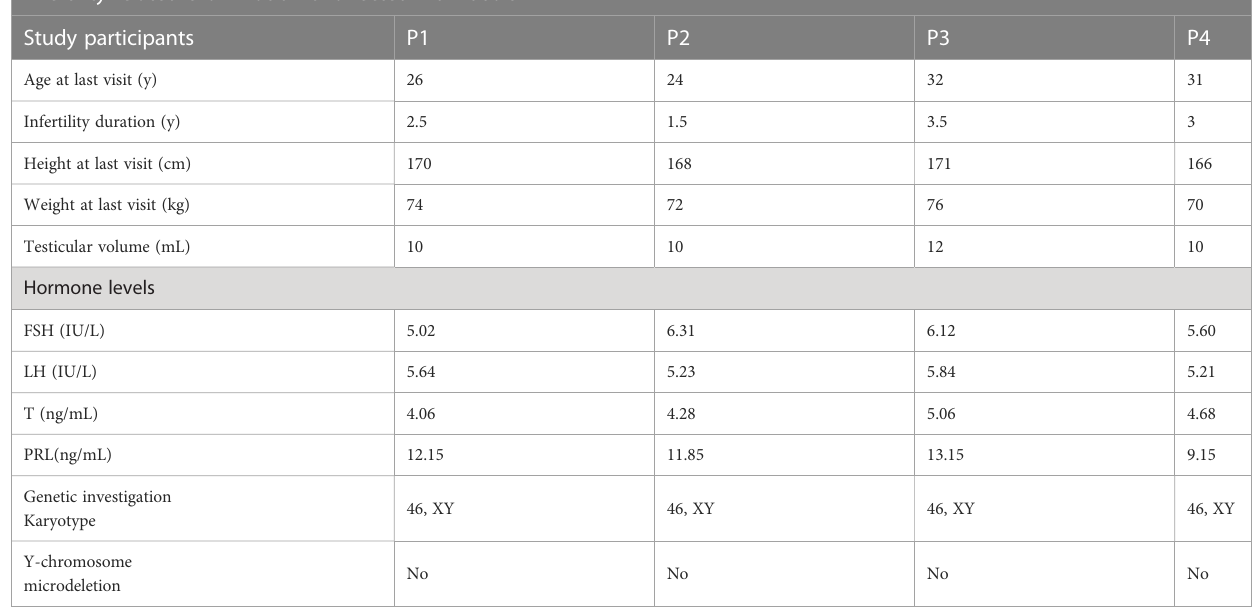
TABLE 1 The clinicopathological variables of four infertile